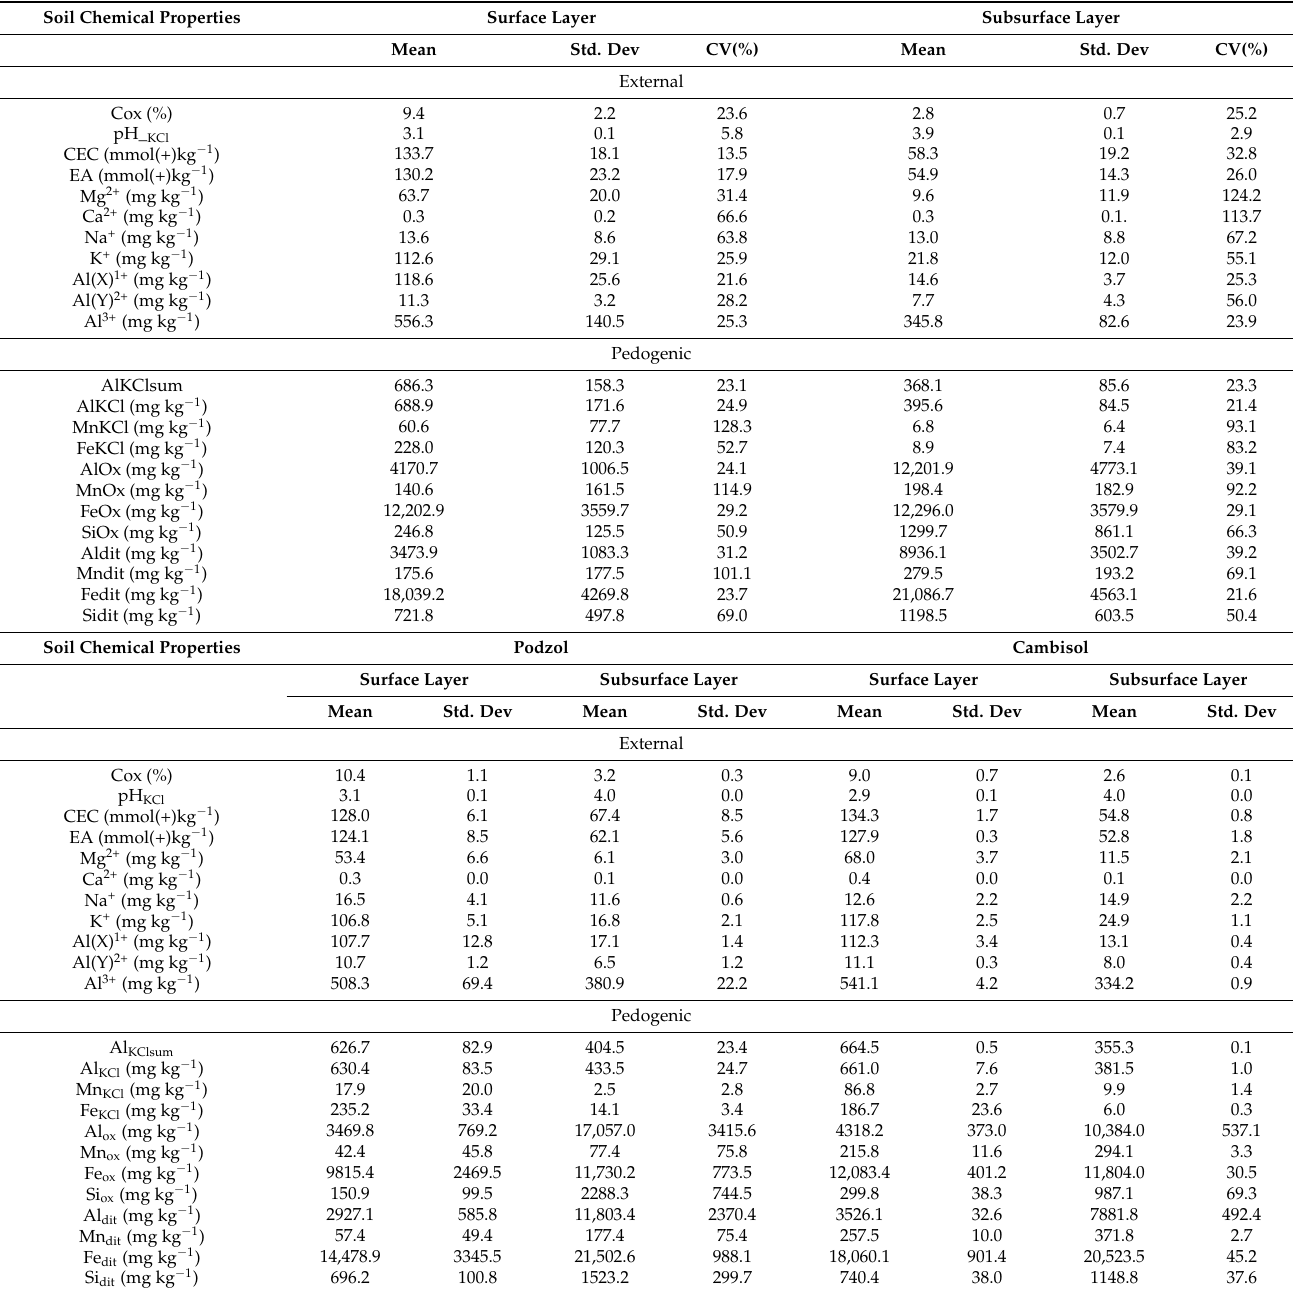
Table 1. Descriptive statistics of the surface and subsurface layers. Specifically, the descriptive statistics of the Podzols and Cambisols in the surface and subsurface layers are also shown (N = 309 samples for the surface and 309 samples for the subsurface layer). Additional informa- tion can be found in Table S2 in the Supplementary